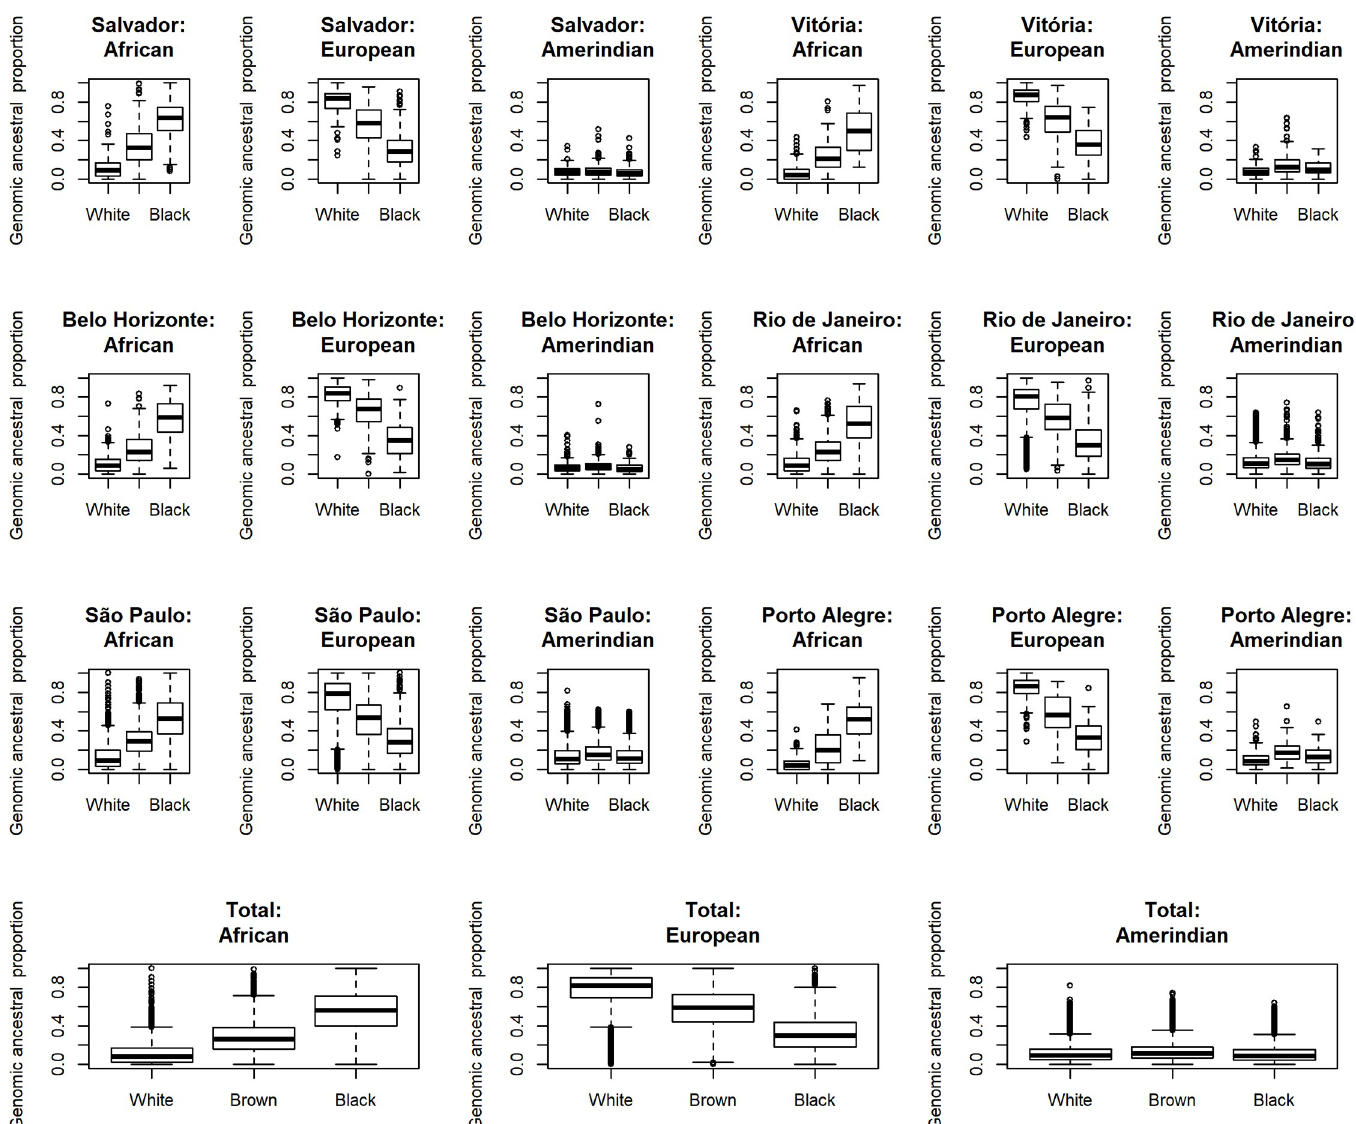
Fig 1. Box plot contrasting ethnoracial self-classification (white, brown and black) to median individual proportion of genomic African, European and Amerindian ancestries in all participants, and by research centre (ELSA-Brasil).